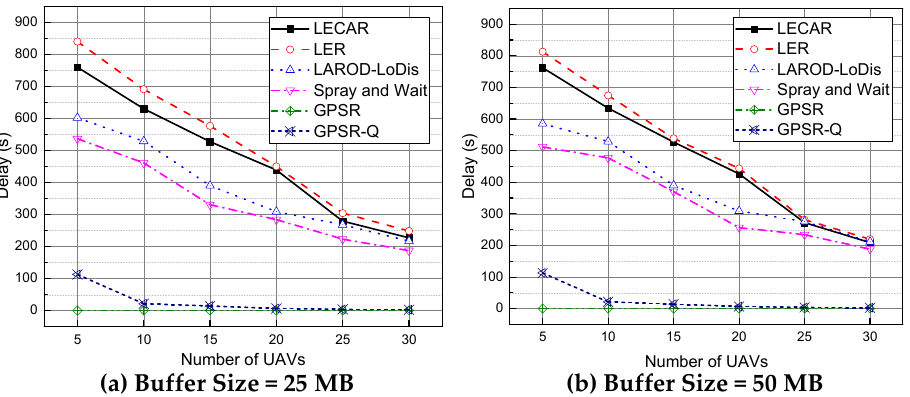
Figure 15. Performance comparison of the routing protocols regarding the delay per packet when the buffer size is ( a ) 25 MB and ( b ) 50 MB.